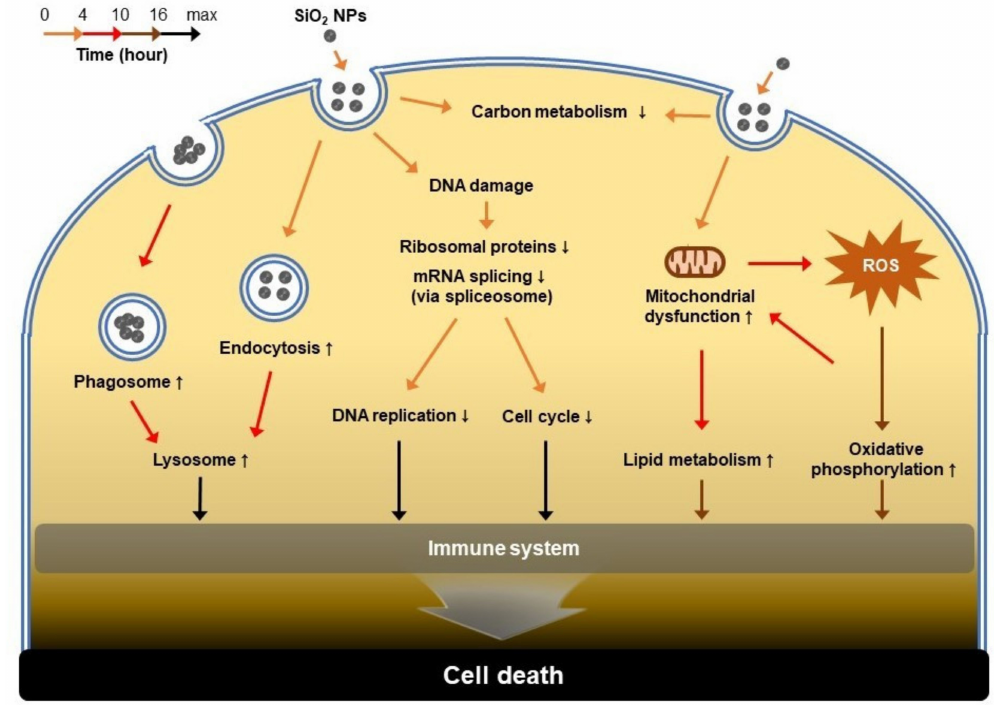
Figure 7. Mechanisms of SiO 2 NP-induced cytotoxicity in HepG2 cells. The order of biological reactions that occur when SiO 2 NPs are exposed to cells is indicated by arrows. Orange, 4 h; red, 10 h; brown, 16 h; black, after 16 h. Responses observed in this study are indicated in bold letters, and those described through reference studies are indicated in light